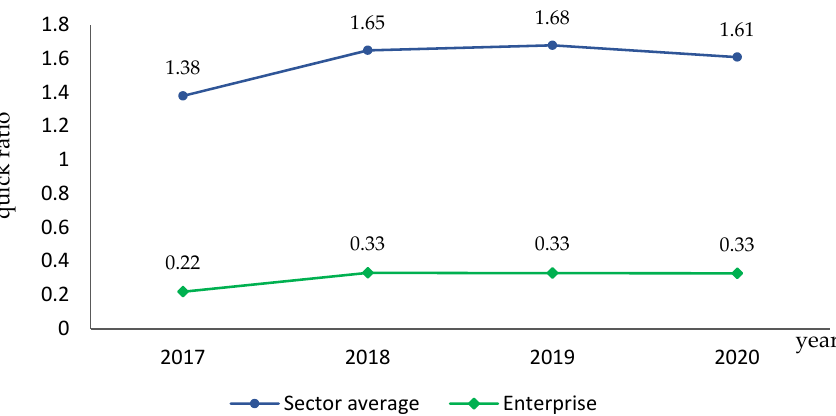
Figure 7. Current ratio ( y 4 ) in the enterprise and in the sector in 2017–2019.